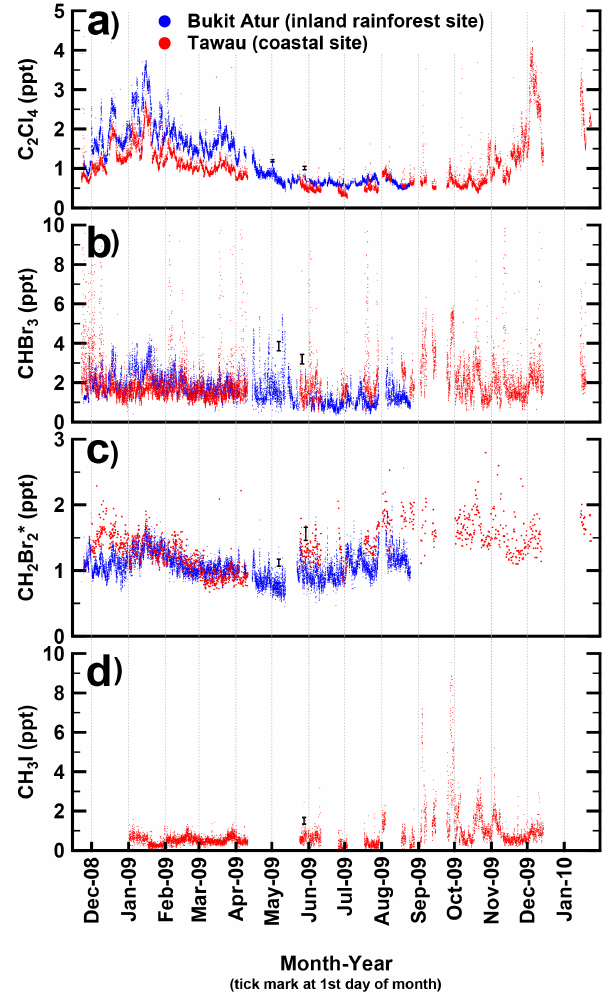
Figure 3. Time series of the four short-lived compounds (a) C 2 Cl 4 , (b) CHBr 3 , (c) CH 2 Br ∗ and (d) CH 3 I at Bukit Atur (blue) and 2 Tawau (red) made between November 2008 and January 2010. High values beyond the scale of the y axis are not shown, but are included in the box-and-whisker plots in Fig. 4. A guide to measurement pre- cision ( ± 1 SD) is shown by the vertical error bars visible in each panel (May 2009) which show the typical precision for each com- pound, at each site, for the full period of data coverage. Gaps in the data are due to a combination of power outages and instrument